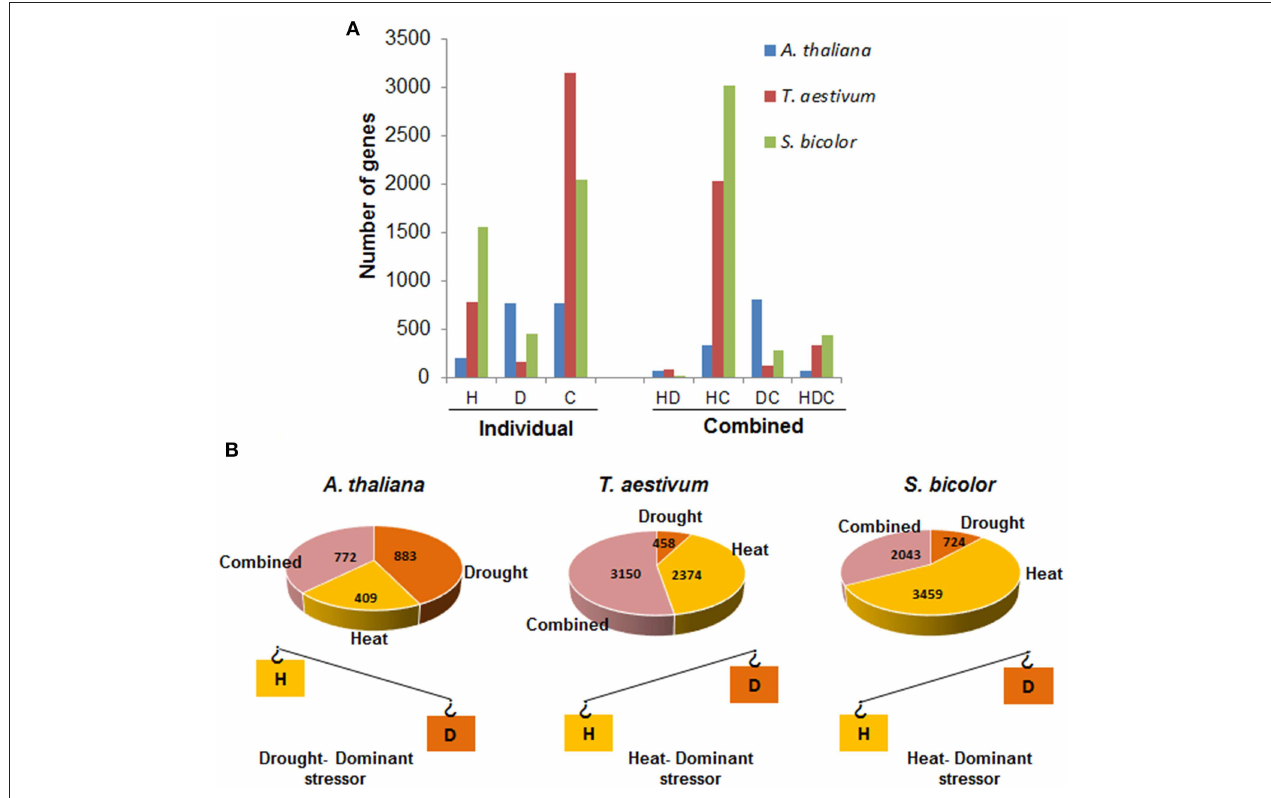
FIGURE 1 | Representation of unique and shared responses and the “dominant stressor” concept in A. thaliana , T. aestivum , and S. bicolor under combined heat and drought stress. (A) H, D, and C denote the number of genes modulated (refer to both up- and down-regulated) exclusively under heat, drought, and combined heat and drought stress, respectively. HD, HC, DC, and HDC represent the commonly regulated genes under heat and drought stress, heat and combined, drought and combined stresses, and all the three stresses, respectively. The figure is a graphical representation of the data (number of genes modulated under the different stress condition) provided in three independent cDNA array studies in A. thaliana , T. aestivum, and S. bicolor by Rizhsky et al. (2004), Aprile et al. (2013), and Johnson et al. (2014), respectively. (B) Representation of the “dominant stressor concept” under combined stress. The rectangles represent heat and drought stress. In a given stress combination, two stresses involved differ in severity of impact on plants. The severity of the two stresses is represented by “see saw.” In case of A. thaliana , the molecular responses seen are drought specific with a maximum overlap between genes modulated under drought and combined stress. In T. aestivum , the number of heat stress specific genes outweighs the number of drought specific genes. However, the number of combined stress-specific genes is far greater than the individual stress specific genes and molecular response to the combined stress conditions is mostly unique in this plant. In case of S. bicolor , the number of genes specific to heat stress outweighs the number of drought stress specific genes. The genes commonly modulated (both up- and down-regulated) under heat and combined stress forms the maximum share in the combined stress response. H, heat; D, drought; C, combined stress. The pie chart represents the molecular response of plants to the combined stress and the area denotes the number of genes modulated under each